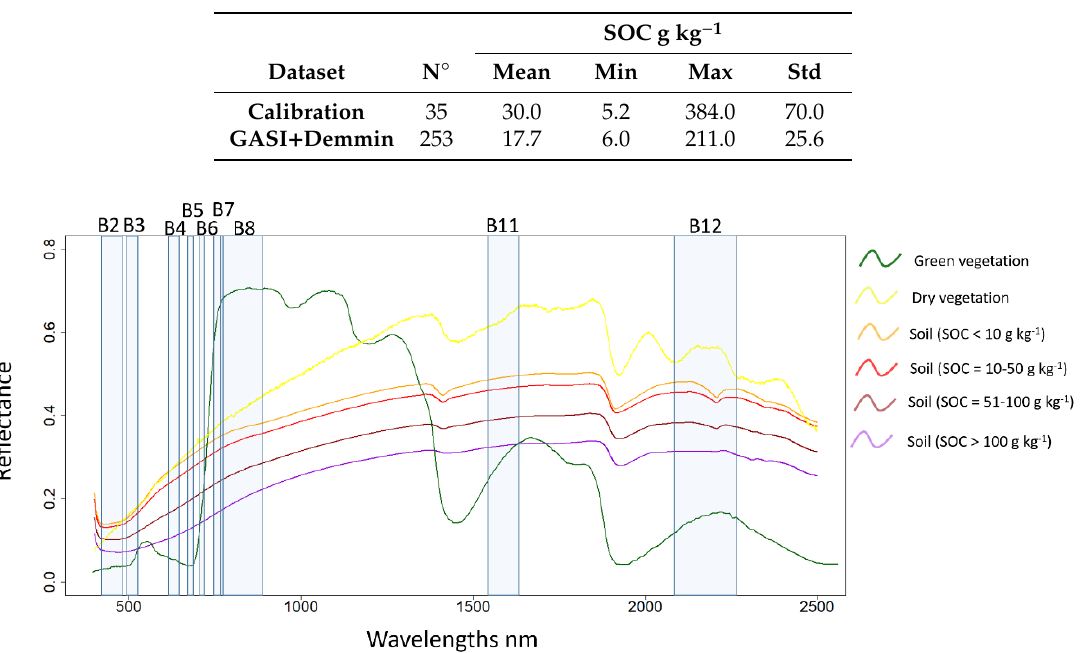
Table 1. Descriptive statistics of the calibration and GASI + Demmin (German Agricultural Soil Inventory) datasets.